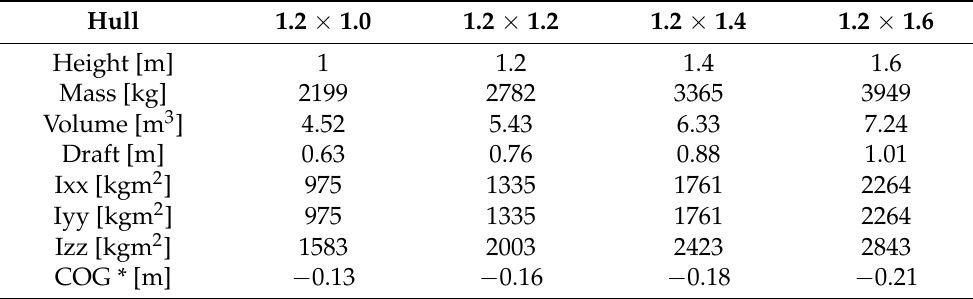
Figure 9. Gross productivity as function of overall hull size. Table 4. Configuration parameters of hull height sensitivity analysis.